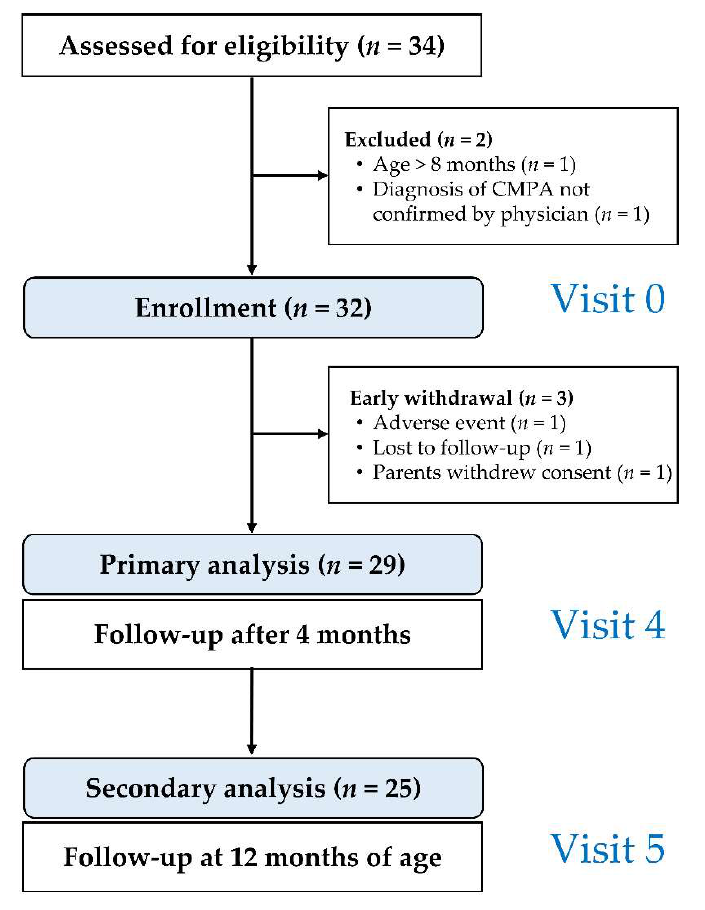
Figure 1. Study flow chart.